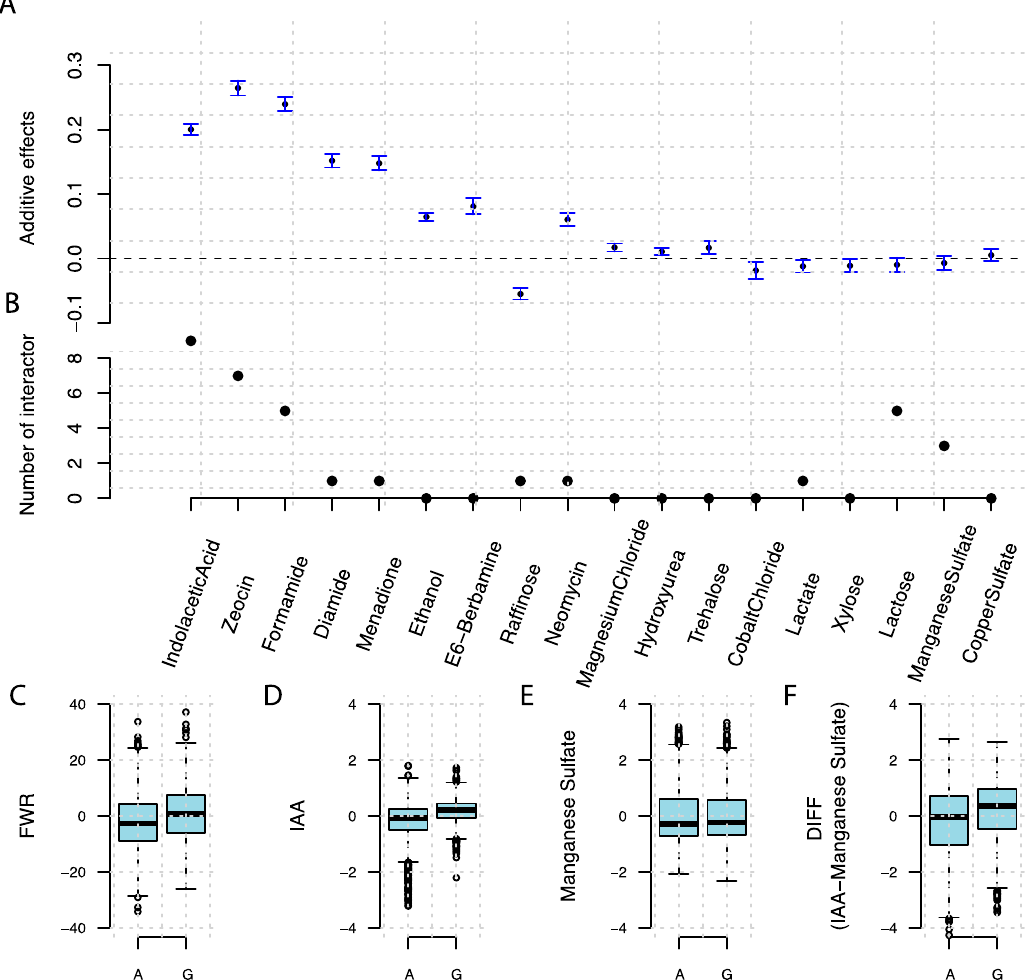
Figure 5. Genetic effects of the epistatic hub locus chromosome 8 (117,586 bp) on trait means, and specific and overall plasticity. ( A ) Marginal additive effects on growth in the 18 media. ( B ) The number of reported epistatic interactors for this hub in the earlier genome-wide exhaustive pairwise epistatic scan [20]. ( C ) Genotype-to-phenotype map for overall plasticity (FWR) measured as the stability parameter of the Finlay–Wilkinson Regression estimated at this QTL, ( D – F ) Genotype-to-phenotype maps for growth measure and on media with added IAA ( D ) or Manganese Sulphate ( E ), as well as the specific plasticity quantified by their pairwise growth differences for the segregants (DIFF, ( F )). Two genotypes were present at this locus, A and G, and the boxplot illustrates the phenotype distributions for these.